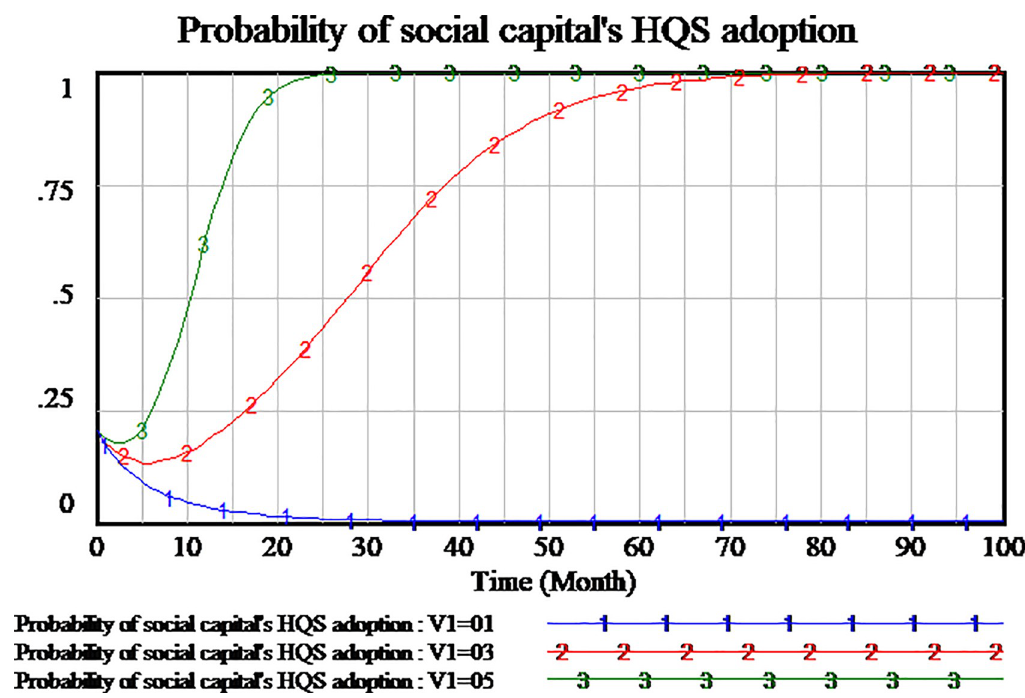
Fig 9. Impact of different penalty on social